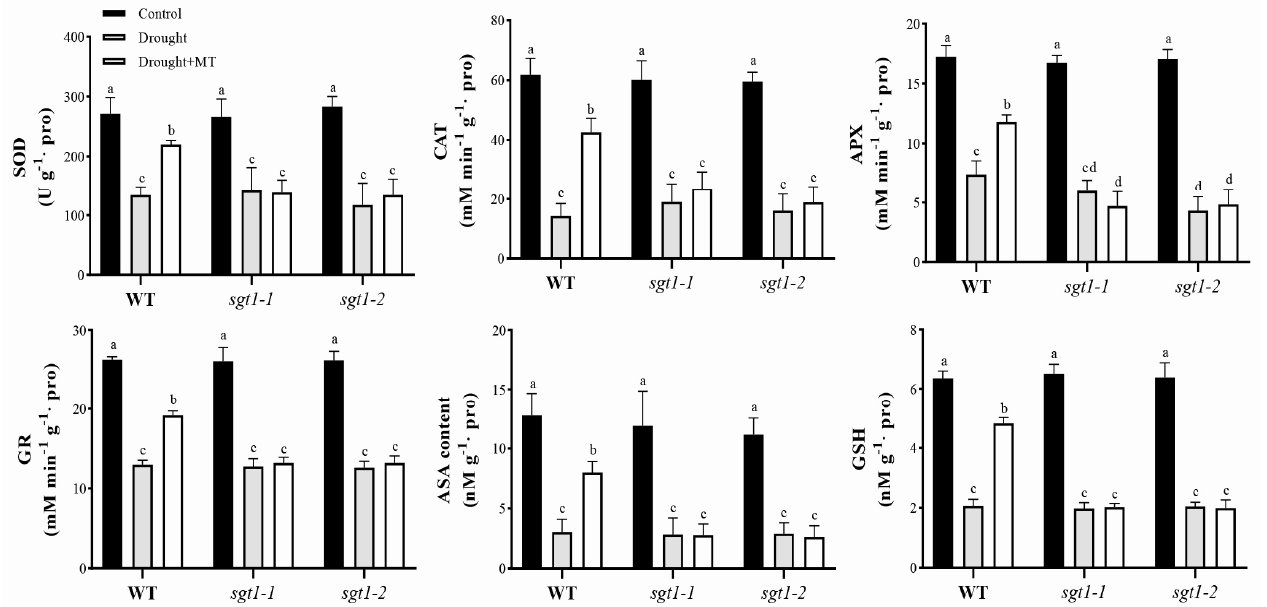
Figure 3. Effects of melatonin treatments on the antioxidant activity under drought stress. Activities of superoxide dismutase (SOD), catalase (CAT), ascorbate (APX), and glutathione reductase (GR), as well as the ascorbic acid (ASA) and glutathione (GSH) contents, were examined in the leaves of wild-type (WT) and sgt1 mutant seedlings treated with melatonin (MT; 100 µM) under drought stress. Difference in letters indicates significant differences according to Tukey’s Multiple Comparison Test ( p < 0.05).